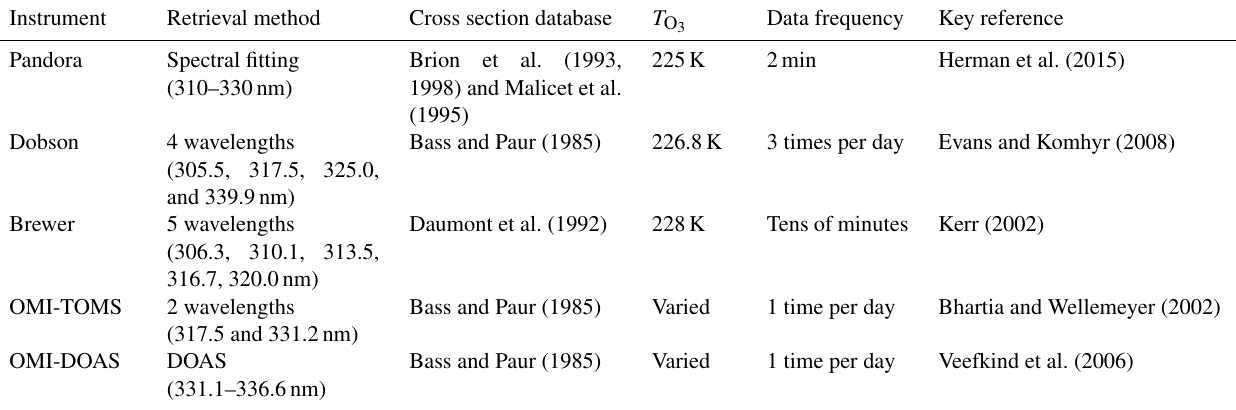
Table 1. TCO retrieval methods with respect to